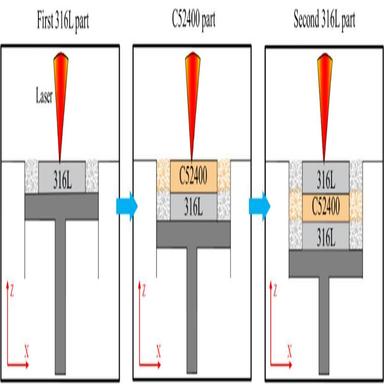
Schematic diagram of additively manufactured dual interfaces of 316L stainless steel and C52400 copper alloy using SLM.